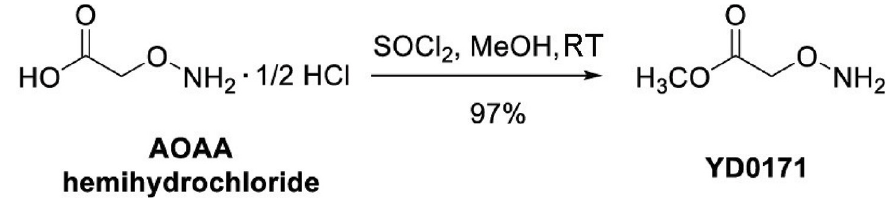
Figure 1. Synthetic route of YD0171. AOAA, carboxymethoxylamine hemihydrochloride, or aminooxyacetic acid, or (aminooxy)acetate; YD0171, methyl